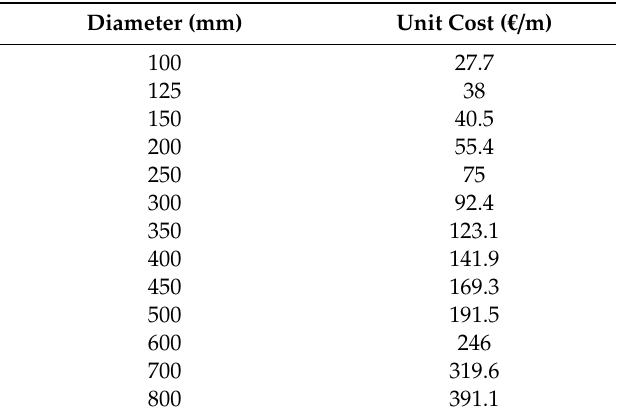
Table 7. Unit costs of Pescara network.